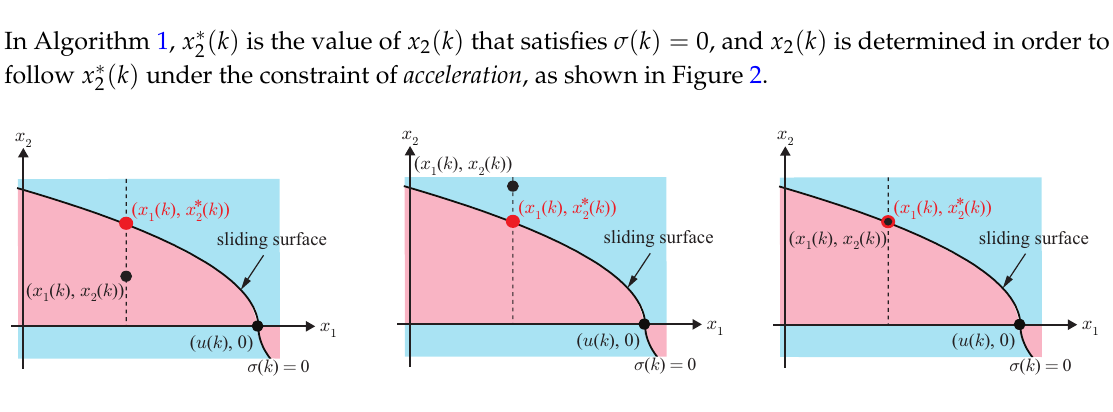
Figure 2. Relationship between x 2 ( k ) and x ∗